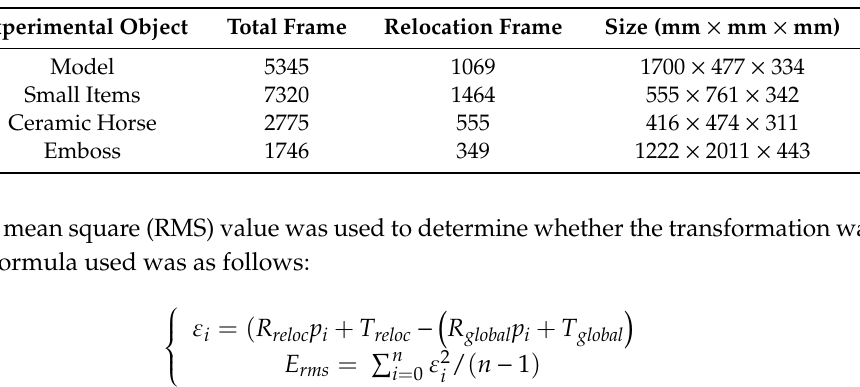
Table 1. Objects for o ffl ine experiments.